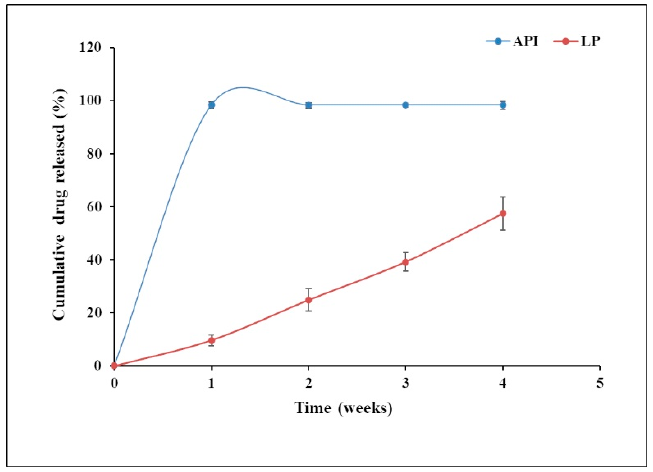
Figure 4. In vitro drug release study of optimized (Batch L6) versus levonorgestrel (API) loaded microneedle.